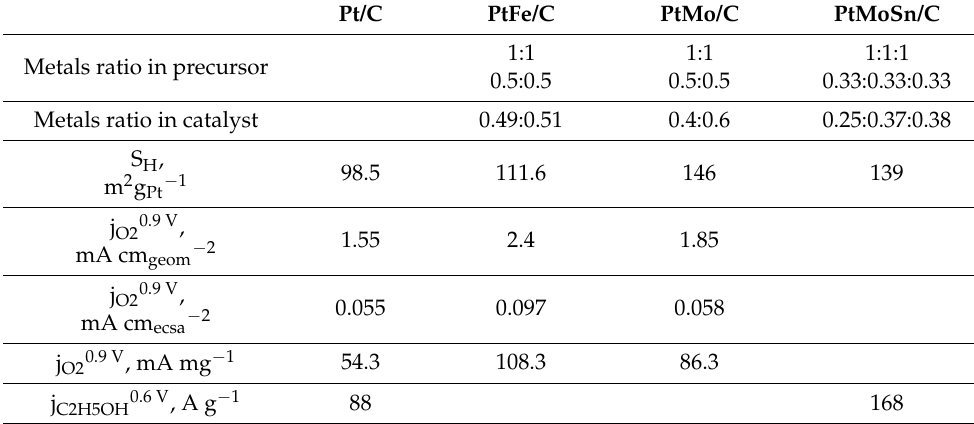
Table 1. Specific characteristics of the prepared PtFe/C, PtMo/C and PtMoSn/C